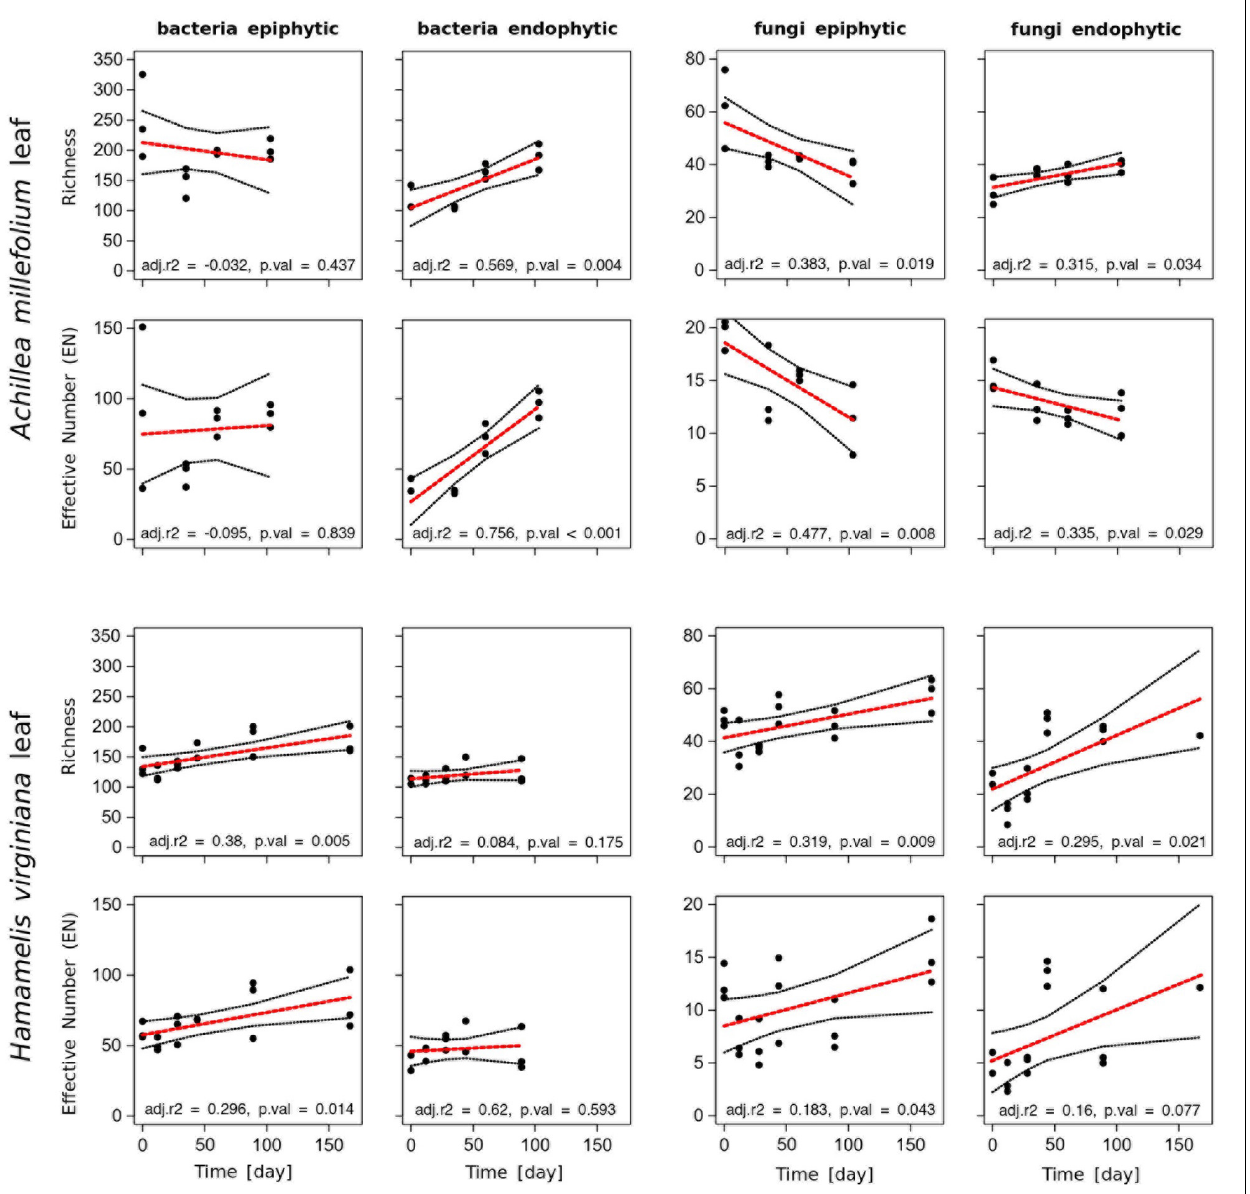
FIGURE 4 | Richness and Effective Number EN of epi- and endophytic bacterial (species) and fungal (genera) communities of leaves of Achillea and Hamamelis between April ( t = 0) and September 2016 ( t = 180) in the WALA garden (location 1a). The dataset was subsampled to 1,000 sequences per sample. The red line fits a linear model with adjusted r 2 value (adj. r 2 ) and significance ( p . val). Missing values for Hamamelis in September (day 167) did not pass the threshold of 1,000 reads and were therefore excluded from this analysis.